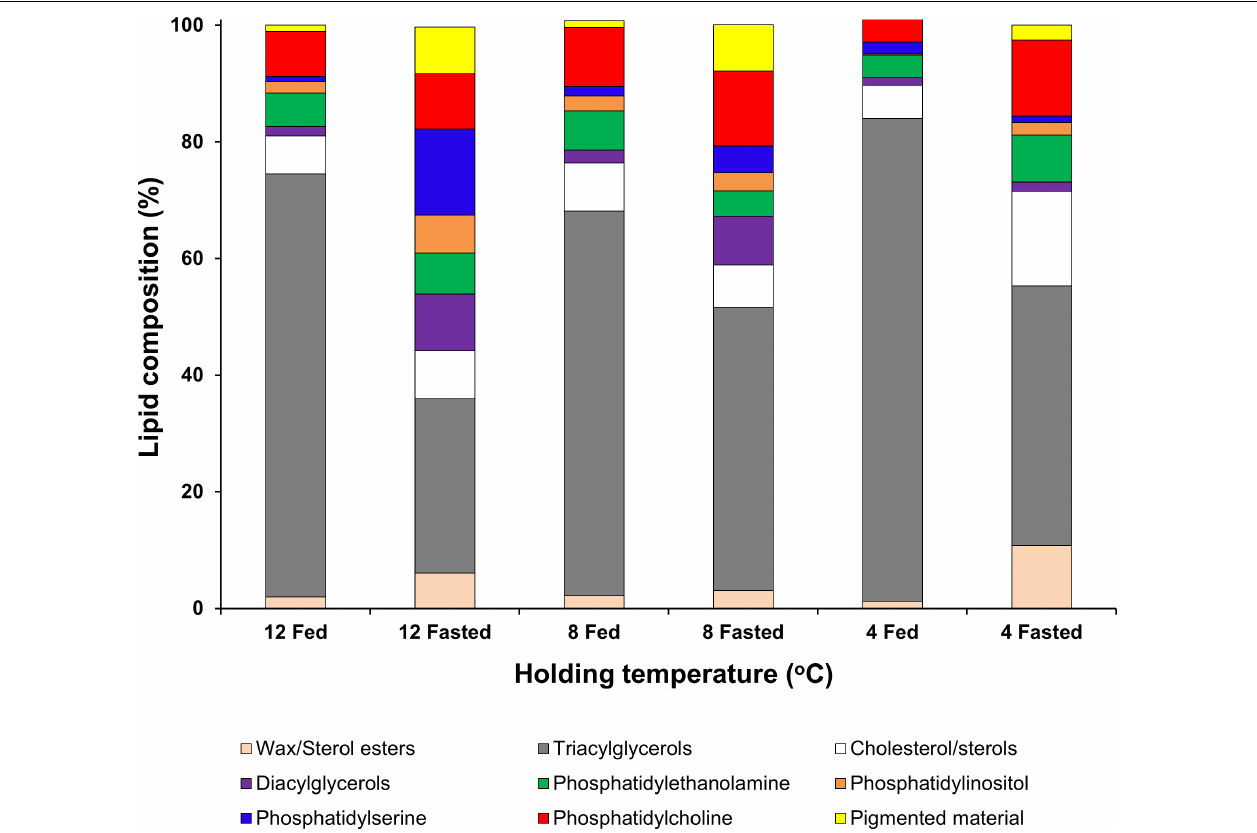
FIGURE 1 | Lipid class analysis in lipid samples extracted from hepatopancreas tissue of H. gammarus after being held for 24 weeks under different conditions. Values represent the mean ± S.E.M ( n = 4).